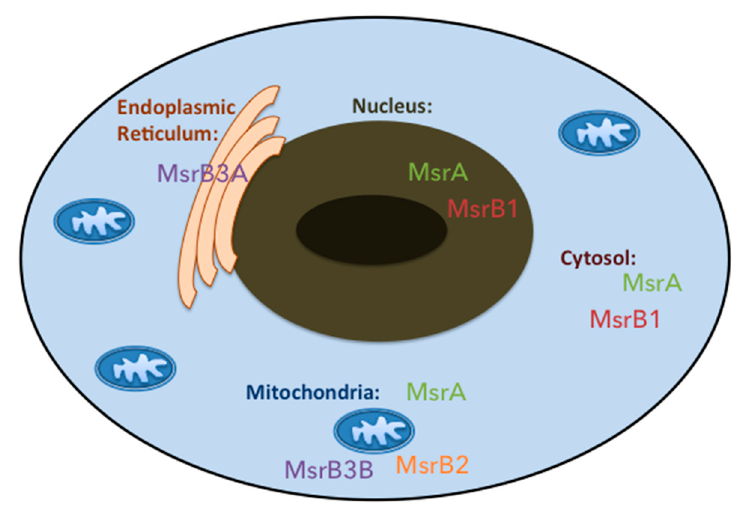
Figure 2. Subcellular distribution of methionine sulfoxide reductase enzymes in humans. MsrA and MsrB1 enzymes are present in the cytoplasm and in the nucleus of human cells. MsrA together with MsrB2 and MsrB3B enzymes can be found within mitochondria. The endoplasmic reticulum only contains a MsrB type enzyme called MsrB3A.